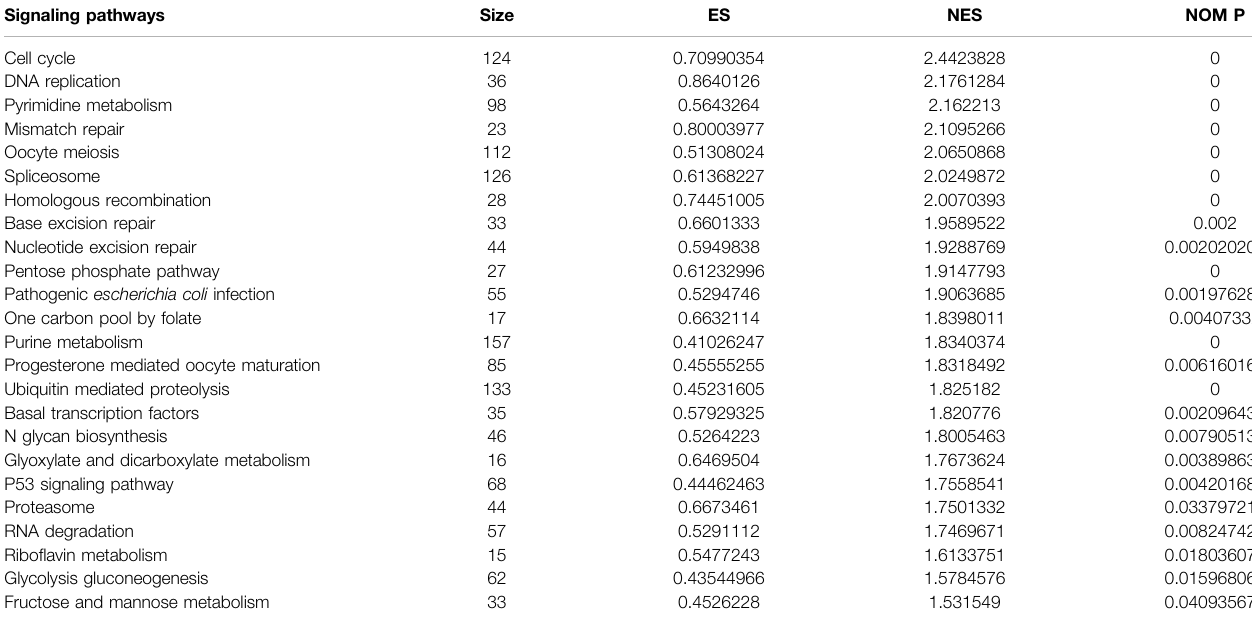
TABLE 6 | Signaling pathways involved in the risk model via the GSEA. Signaling pathways Size ES Cell